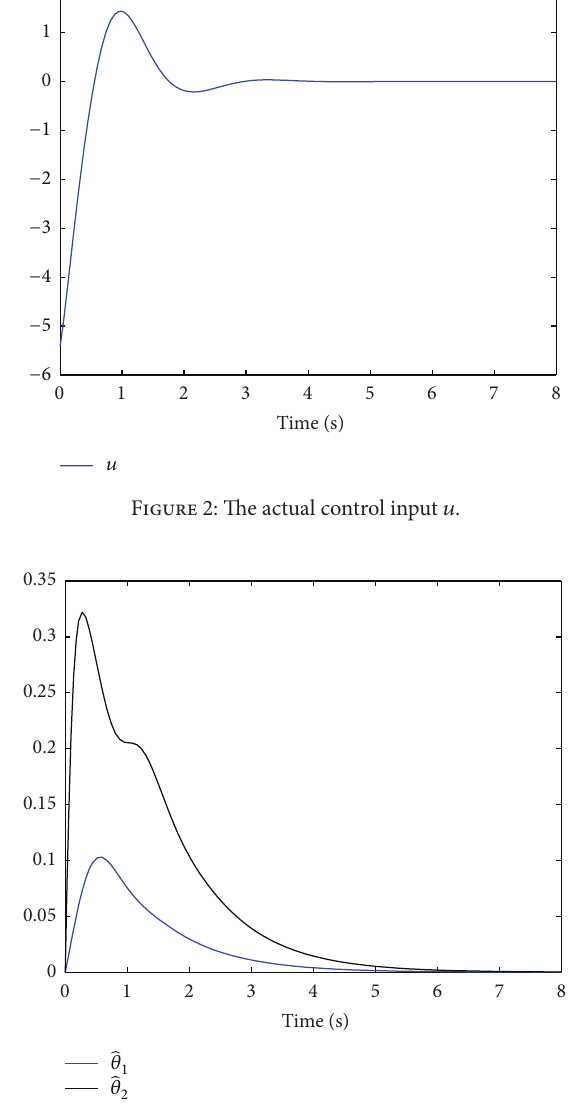
Figure 3: The adaptive parameters